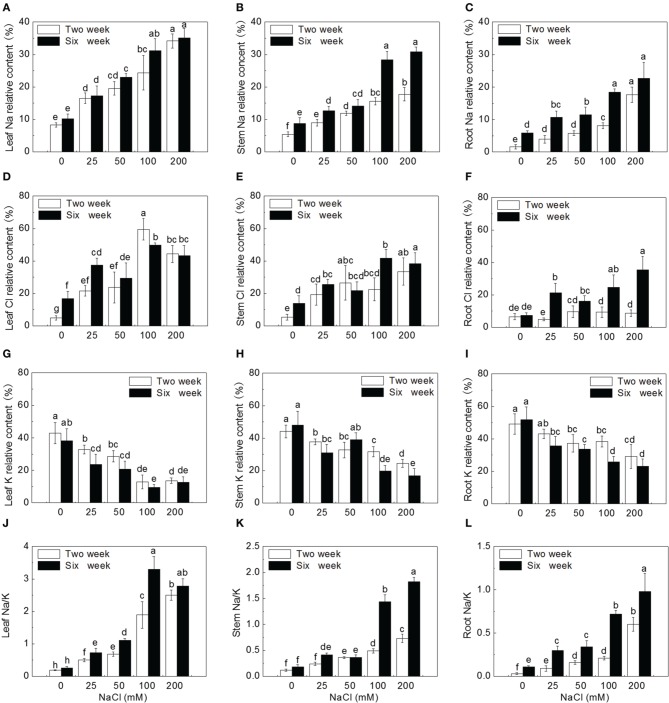
Ion relative content and Na/K ratio under different concentrations of NaCl using SEM-EDS. (A) Leaf Na relative content, (B) stem Na relative content, (C) root Na relative content, (D) leaf Cl relative content, (E) stem Cl relative content, (F) root Cl relative content, (G) leaf K relative content, (H) stem K relative content, (I) root K relative content, (J) ratio of Na to K in leaf, (K) ratio of Na to K in stem, (L) ratio of Na to K in root. Values are means and bars indicate SDs (n = 6). Columns with different letters indicate significant difference by Duncan's multiple range tests at P < 0.05 (Duncan test).